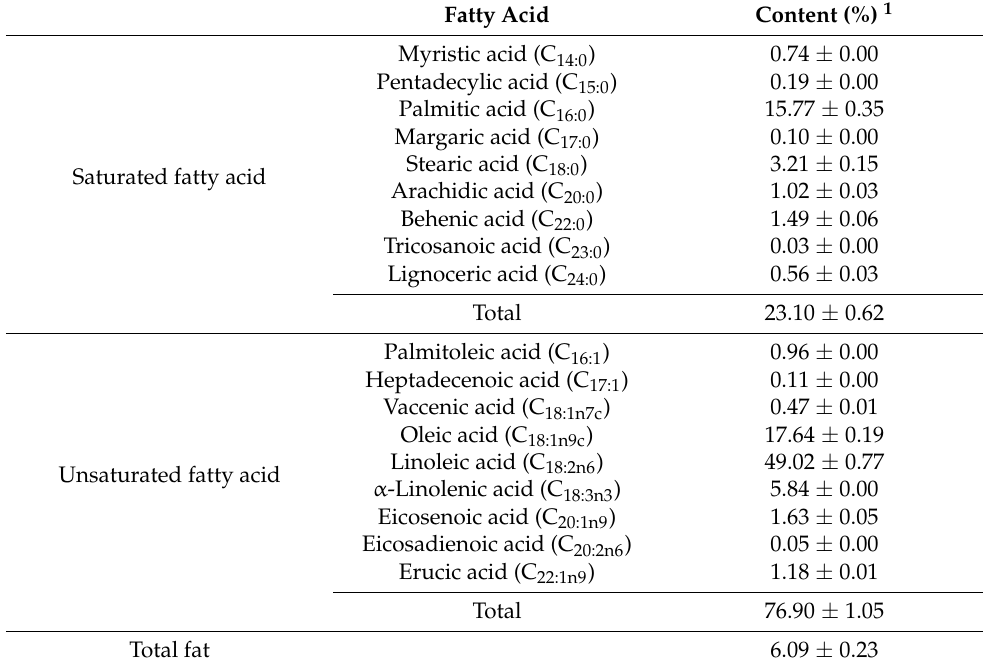
Table 1. Fatty acid composition of